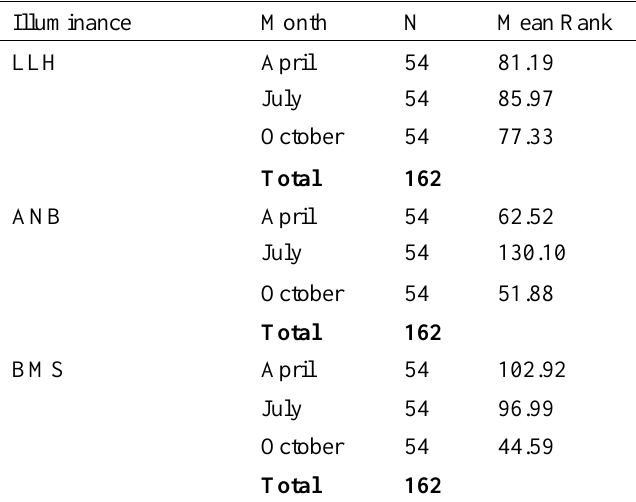
Mean ranking of illuminance distribution per month of each strategy